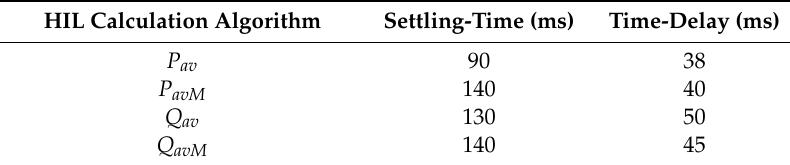
Table 7. Settling-time and time-delay for active and reactive power.